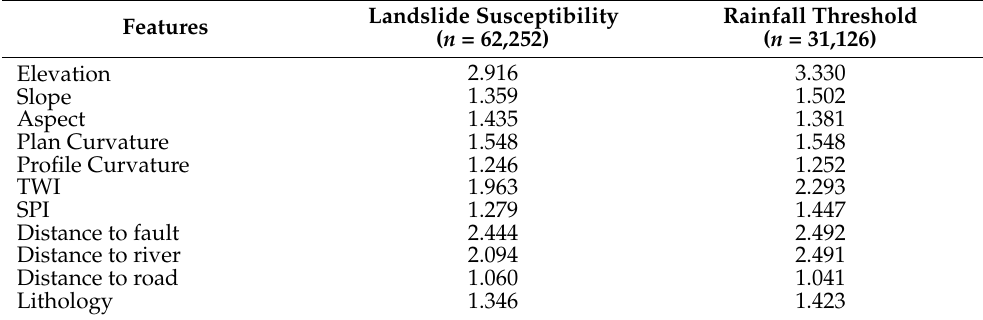
Figure 7. Pearson correlation coefficient between factors for training datasets. ( a ) Landslide suscepti- bility classification model; ( b ) rainfall threshold regression model. Table 3. The VIF results of each factor for training datasets of landslide susceptibility and rainfall threshold regression